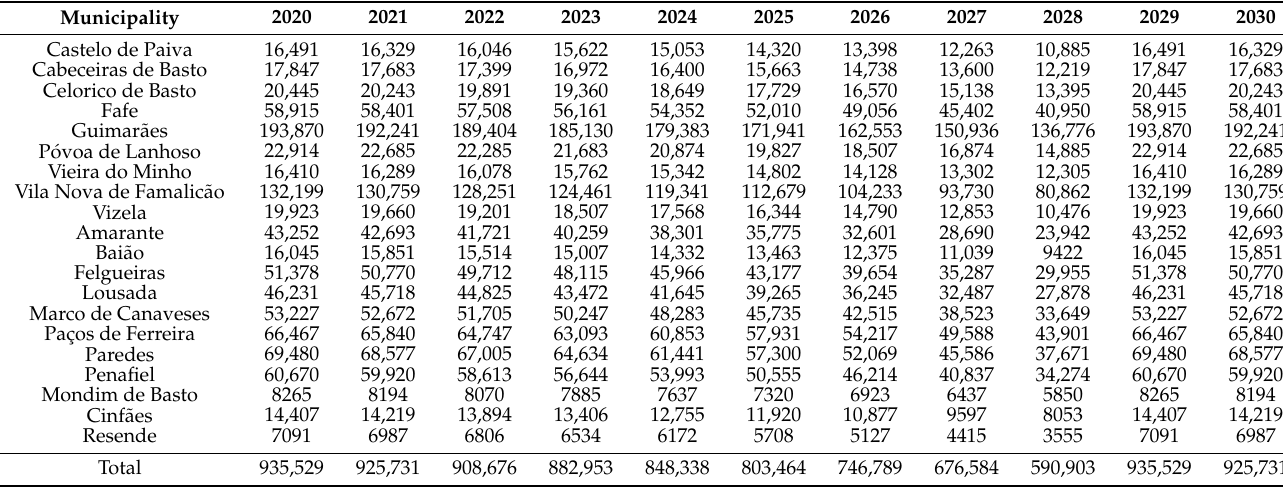
Table A3. Scenario 1: Impacts (available power–required power) of the BEV fleet on the grid during off-peak hours (values in kVA).